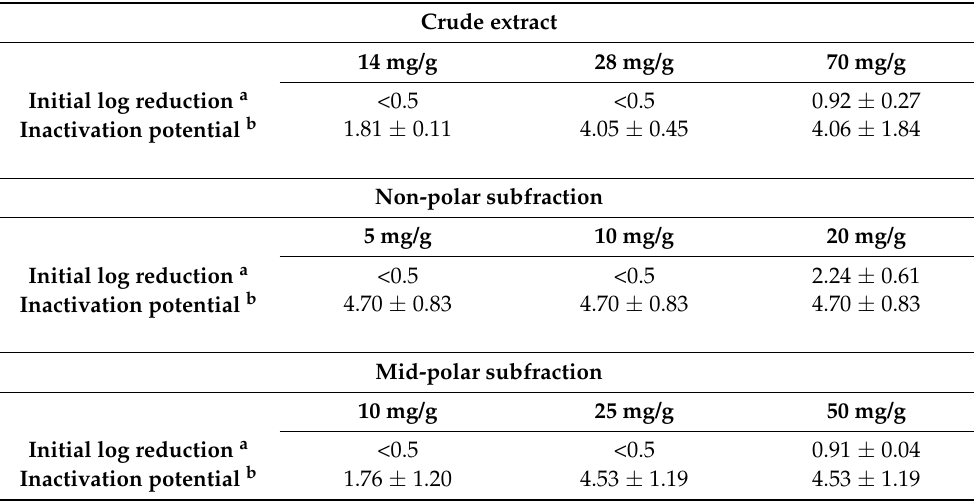
Table 1. Log reduction in B. cereus (log 10 ; mean ± standard deviation) in fresh cheese inoculated with three different concentrations of crude extract and its two corresponding